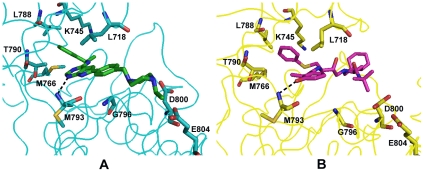
Comparative Interactions between EGFR and Inhibitor (PDB ligand id AEE; A) and EGFR and Nelfinavir (PDB ligand id 1UN; B).A: Cyan ribbon represents the backbone structure of EGFR bound to AEE (green). Cyan sticks represent the residues in contact with AEE. Black dash line represents hydrogen bonding interactions between AEE and EGFR. The distance between N and N is 3.22 Å. B: Yellow ribbon represents the backbone structure of EGFR bound to Nelfinavir. Yellow sticks represent the residues in contact with Nelfinavir. Black dash line represents hydrogen bonding interactions between Nelfinavir and EGFR. The distance between N and O is 3.16 Å.